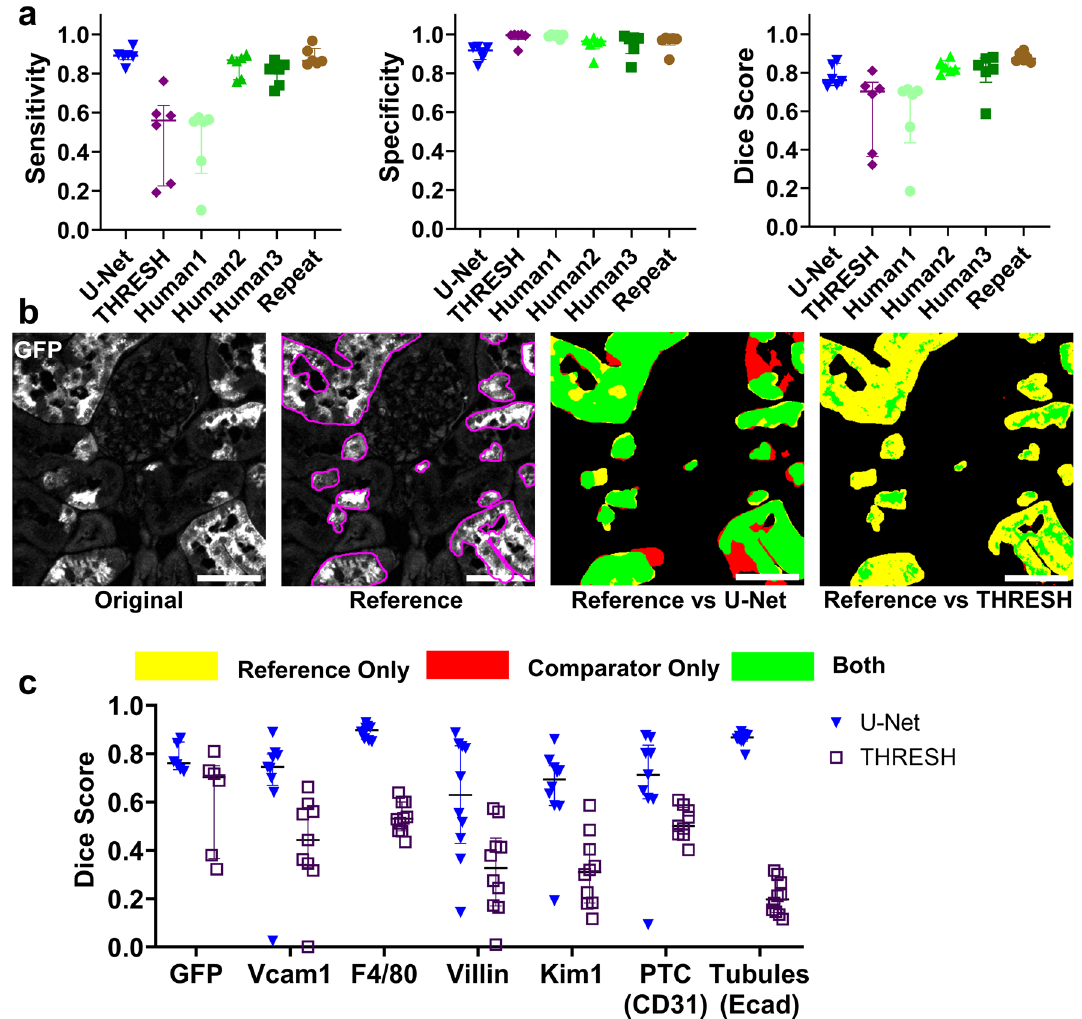
Figure 2. U-Net segmentation performance is similar to human annotation and is superior to thresholding for membrane-targeted stains. ( a ) U-Net model for identifying GFP positive proximal tubule cells was trained as described. Random sample ROIs were extracted from U-Net segmentations of whole kidney sections and compared with ROIs annotated by a reference expert observer to generate pixel-wise sensitivity, specificity and Dice score for each image. Median + interquartile range are shown. Performance was also compared with thresholding of a background subtracted section using ImageJ defaults (THRESH), three independent trained human annotators (Human1, Human2, Human3), and the reference observer’s re-annotation of blinded, randomly reordered, randomly rotated ROI images (Repeat). ( b ) Examples of one validation ROI image showing the original image, the outlines of the reference observer (magenta), and the comparison of the reference observer with U-Net segmentations and thresholding. Scale bar 50 μm. ( c ) U-Net models were trained for several additional membrane localized stains (Vcam1, F4/80, villin) as well as stain-defined structures Kim1 + tubules (Kim1), peritubular capillaries (PTC, marked by CD31), and tubules (marked by E-cadherin, Ecad). Performance was compared with